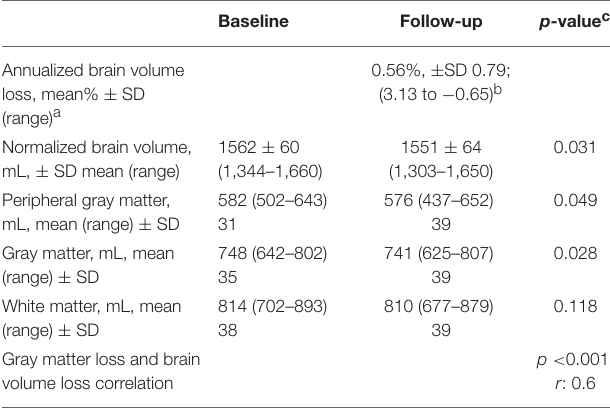
Baseline Follow-up p -value